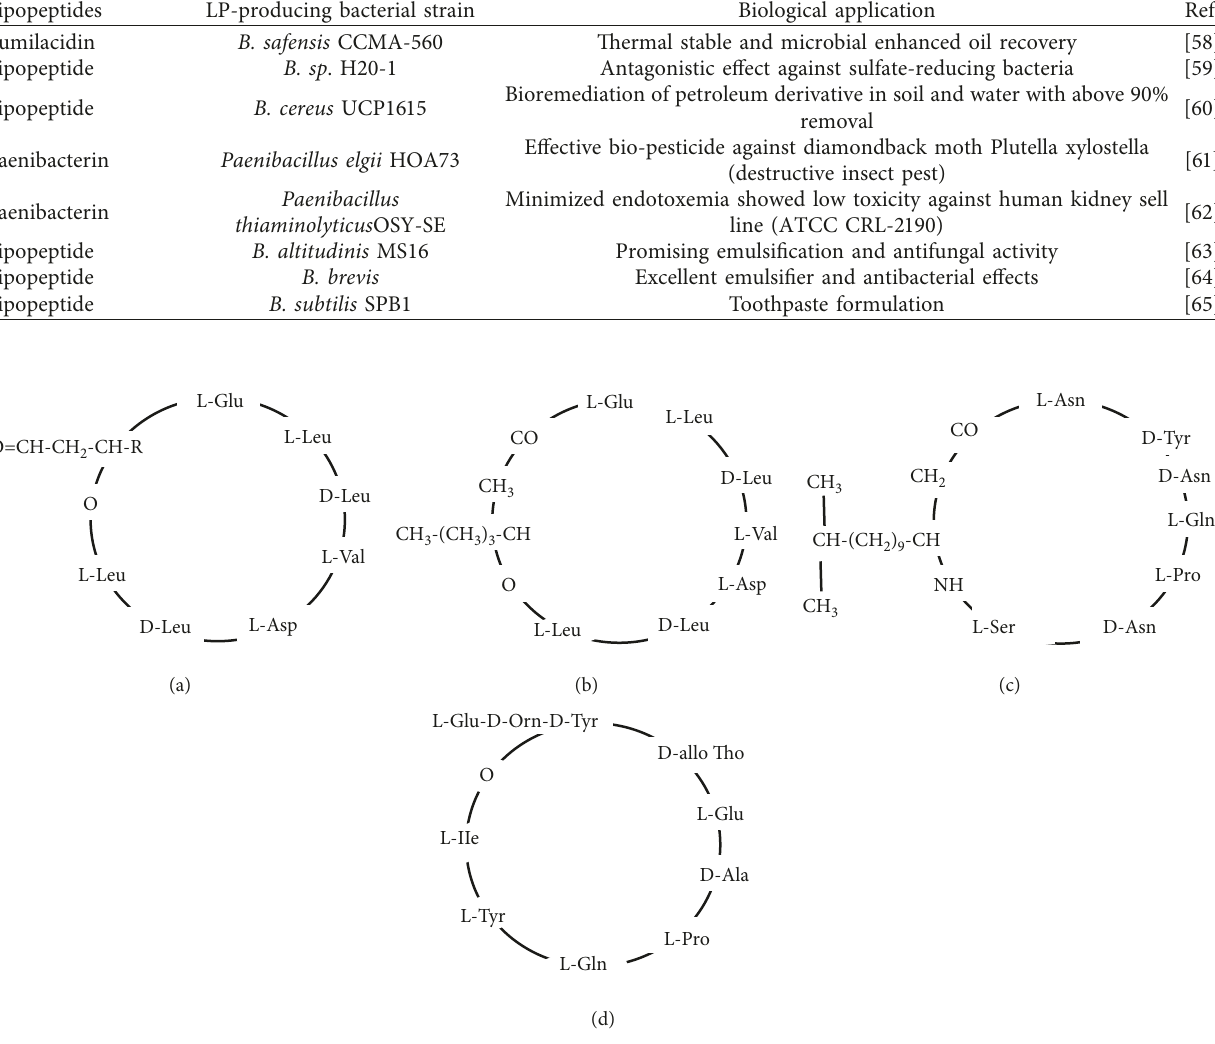
Figure 1: Chemical structures of some lipopeptides: (a) surfactin, (b) lichenysin, (c) iturin, (d)